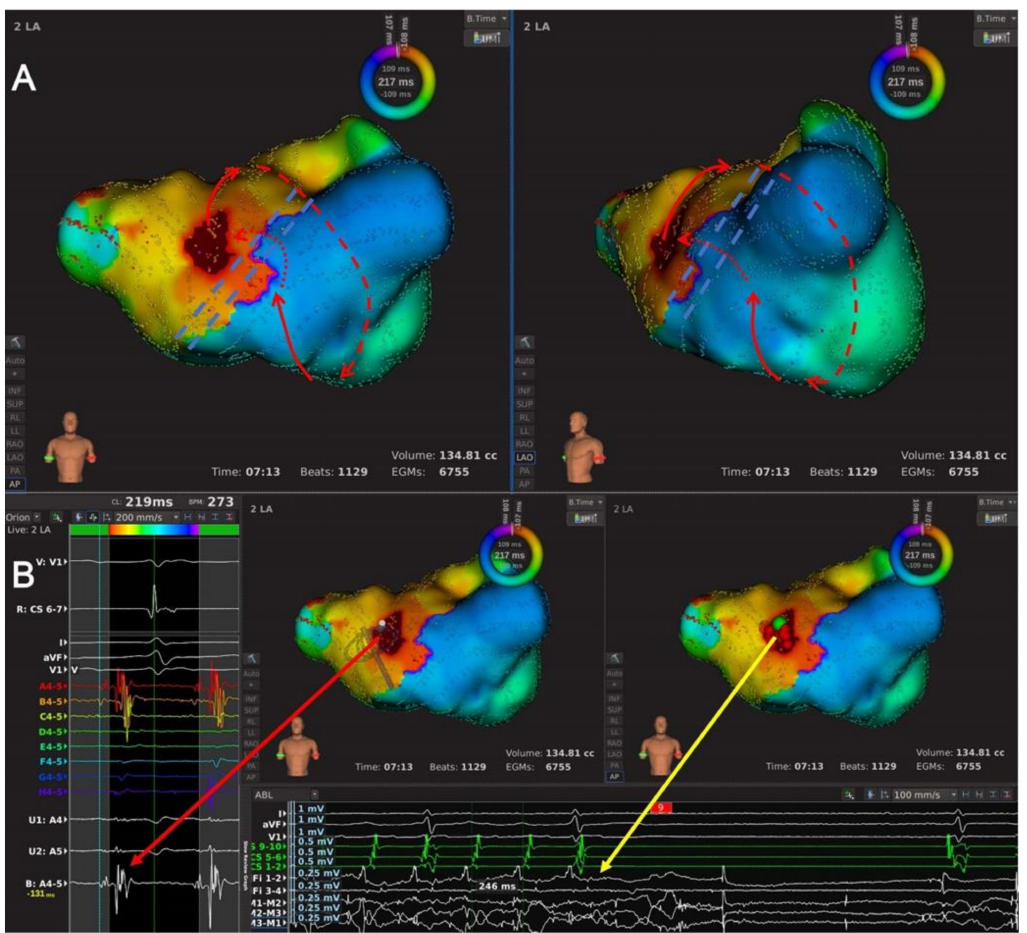
Figure 6. The high-density mapping of a Type 2.2 AT. ( A ) Activation map of a Type 2.2 AT from the anteroposterior view (left) and the left-anterior oblique view (right). The high-density mapping identified one LAAW block line stretching from LA septum extending to LA roof. The wavefront ran down the LA posterior wall, turned around the MI and activated LAAW, then jumped across the LAAW block line via the epicardial bypass and activate the other side in an areal pattern. Then the wavefront went upward around the LA roof and returned to the LA posterior wall. The red lines with arrows indicated the circuit of AT; the dashed red line indicated the epicardial bypass of the AT circuit; the dotted red line indicated the epicardial bypass; the double-dashed blue line indicated the LAAW block of line. ( B ) Local map potentials of the LAAW gap during AT (left) and at the moment of AT termination (bottom). The red dots indicated the ablation points; the green dot indicated the termination site; the arrowed red and yellow lines indicated the local potentials during AT and at the moment of AT termination,